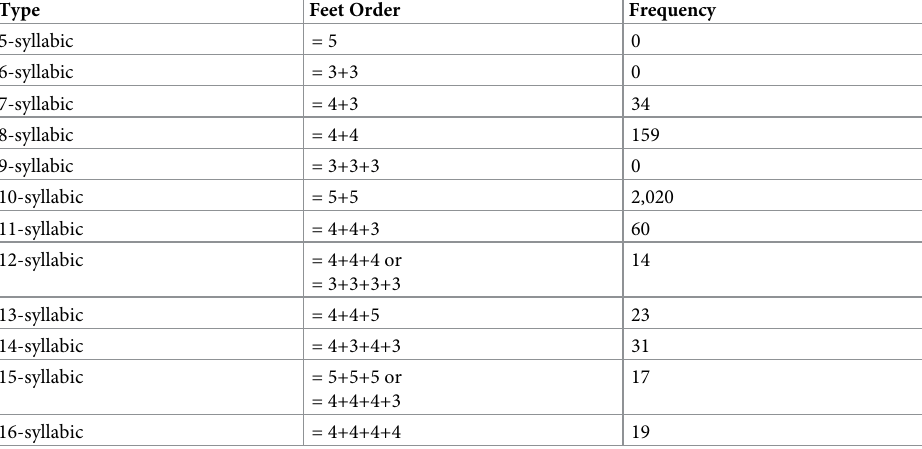
2.2.2 Quantitative verses. The quantitative meter is an arrangement of heavy ( ˉ ) and light (˘) syllables in a line of the poem, as is found in Greek and Latin poems [17]. This type of meter fits languages like Arabic, where the vowel length is distinctive and changes the mean- ing. Arabic has three short vowels [a i u] with distinctive long pairs [ aː iː uː ] [18]. For example, in the following Arabic hemistich by Hafez (1325–1390), all vowels are pronounced with their